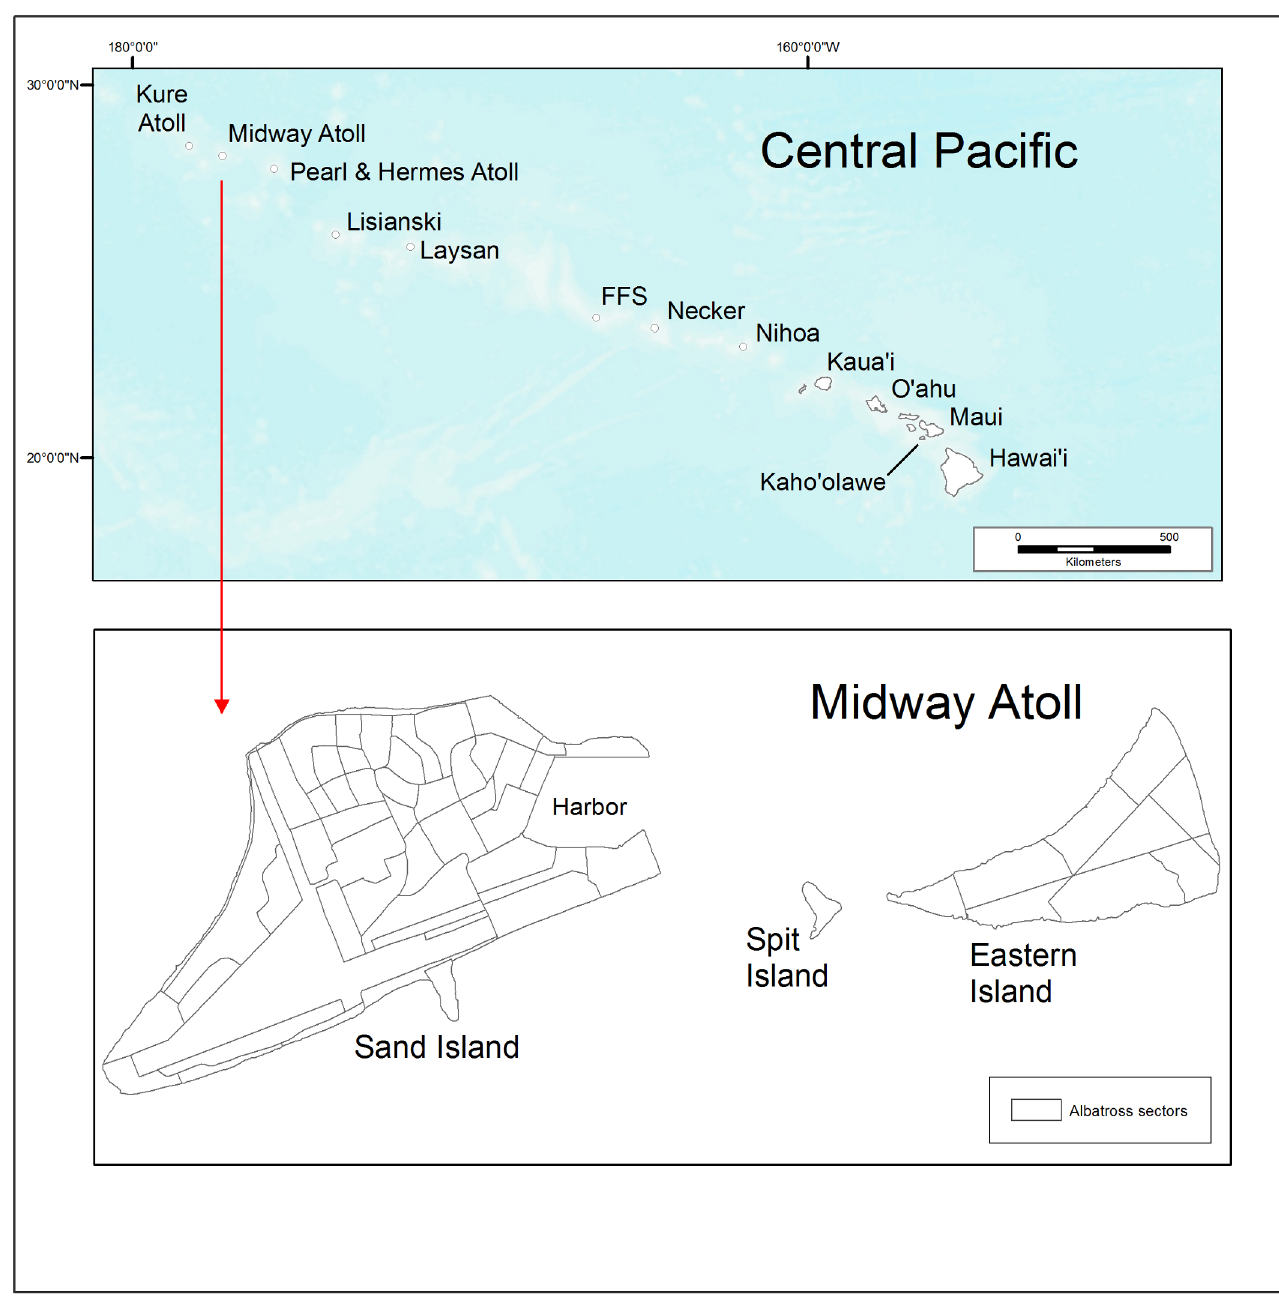
Fig 1. Map of the Hawaiian Islands in the Central Pacific Ocean, including Midway Atoll showing year 2011 albatross census